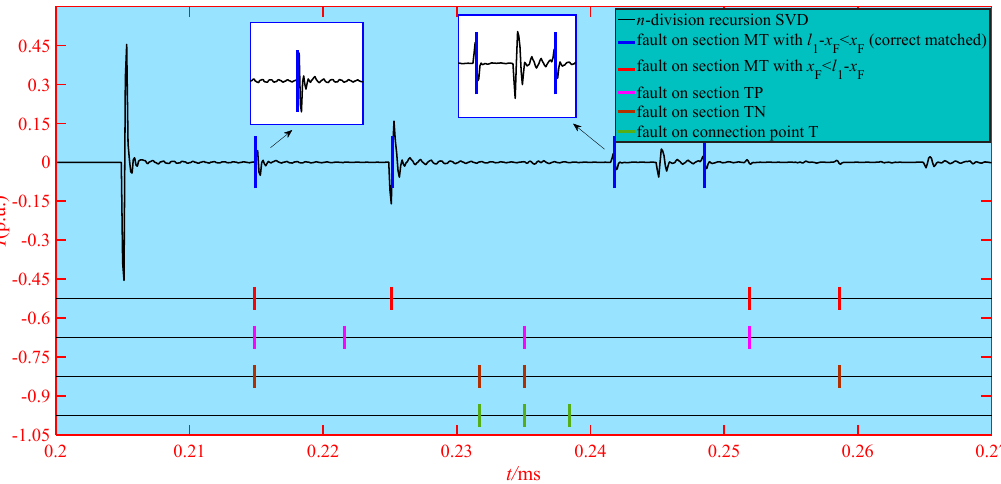
Figure 10. Full-line matching algorithm for section l 1 fault and matching results with n -division recursion SVD.